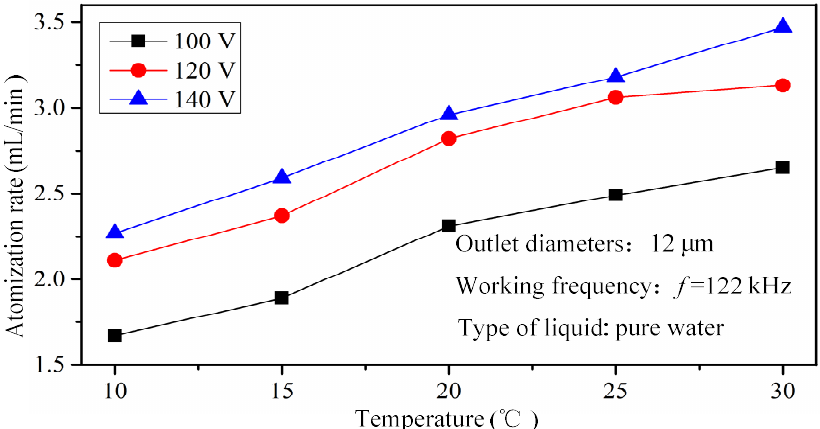
Table 5. Atomization rate of pure water at different temperatures.